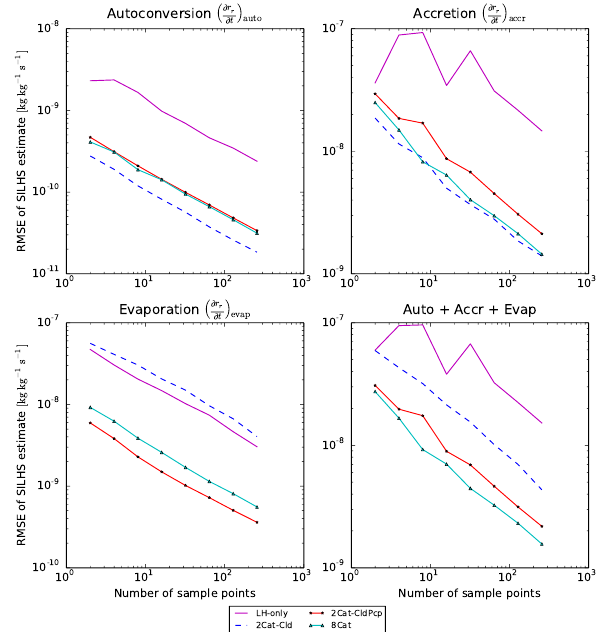
Figure 1. RICO: the root-mean-square error (RMSE) at the im- portance sampling level of SILHS simulations as a function of the number of sample points, for the RICO cumulus case. The error is time-averaged over the entire simulation. The 2Cat-CldPcp and 8Cat methods show a large improvement over the 2Cat-Cld and LH- only methods in the estimate of evaporation, but not for autoconve- sion and accretion, which are in-cloud processes. Nevertheless, the 8Cat and 2Cat-CldPcp methods both impove the estimate of the sum of the three